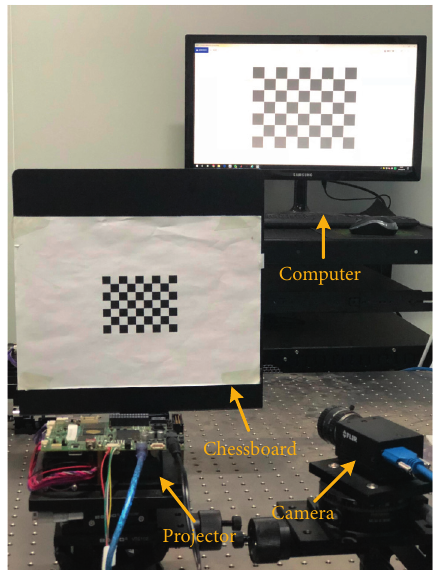
Figure 8: Hardware implement.